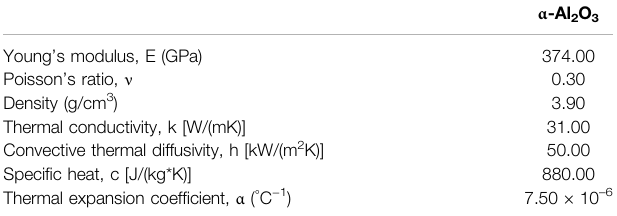
TABLE 1 | Reference values of model parameters (Li et al., 2013).